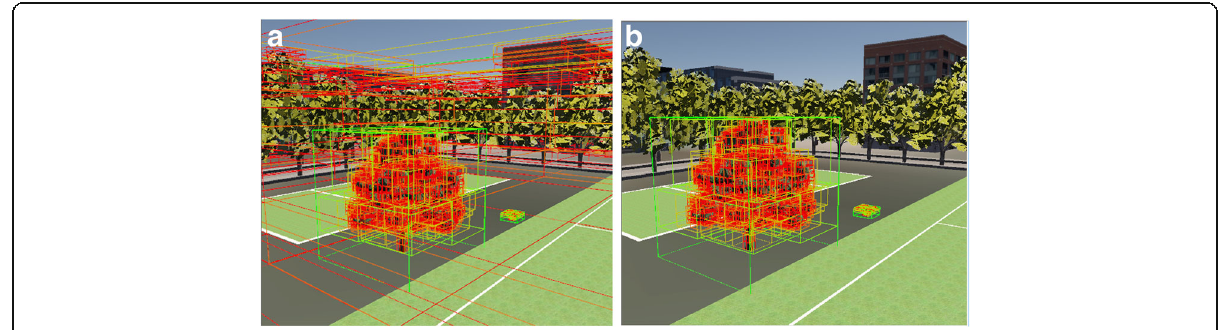
Fig. 7 The structures of possible colliders. a Results adopted by traditional collision detection; b Results adopted by our